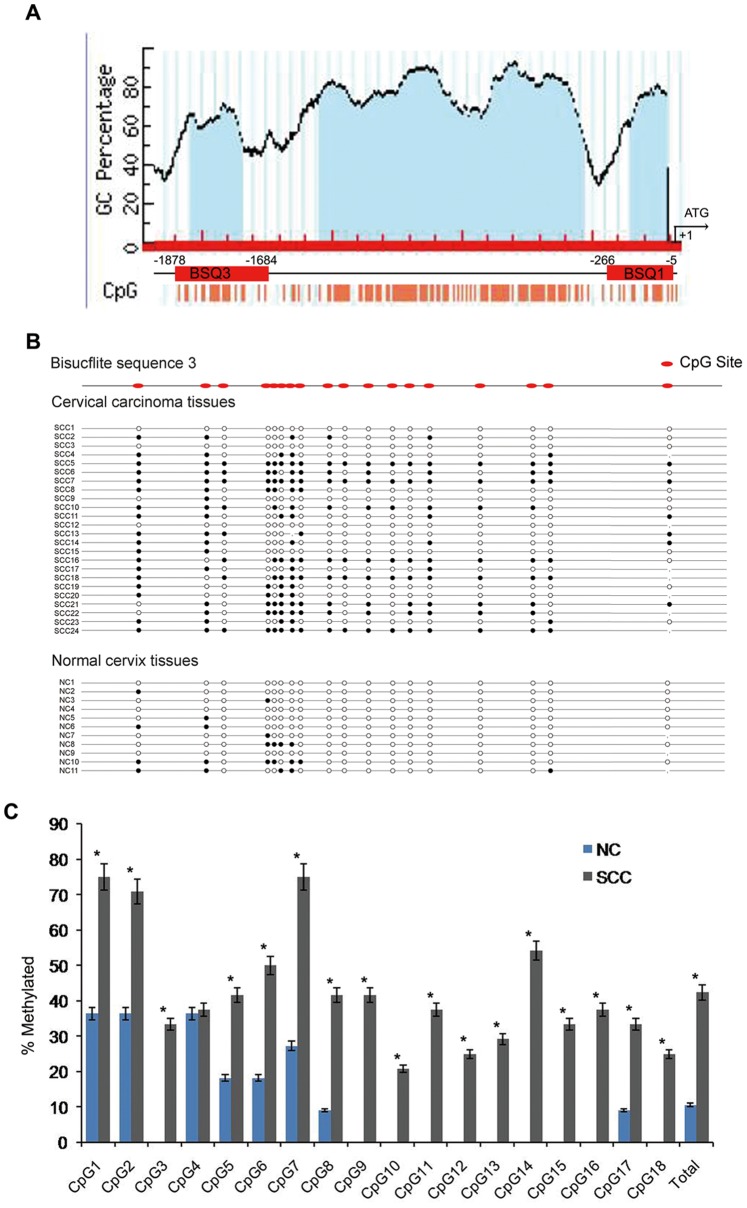
The KLF4 promoter region is hypermethylated in cervical cancer.(A) A schematic representation of the CpG islands found in the promoter region of the KLF4 genomic locus. Numbers indicate positions in bp relative to the transcription start site. The two CpG island regions marked in red were bisulfite sequenced. (B) Bisulfite-converted DNAs from cervical cancer tissues (n = 24) and normal tissues (n = 11) were amplified at the KLF4 promoter, and the fragments were sequenced. CpG sites are represented as boxes, with shaded regions indicating methylation, and unshaded regions indicating no methylation. (C) The methylation level ratio of the CpG sites in cervical cancer and normal cervix tissues. Bars, SE. *, P<0.05.